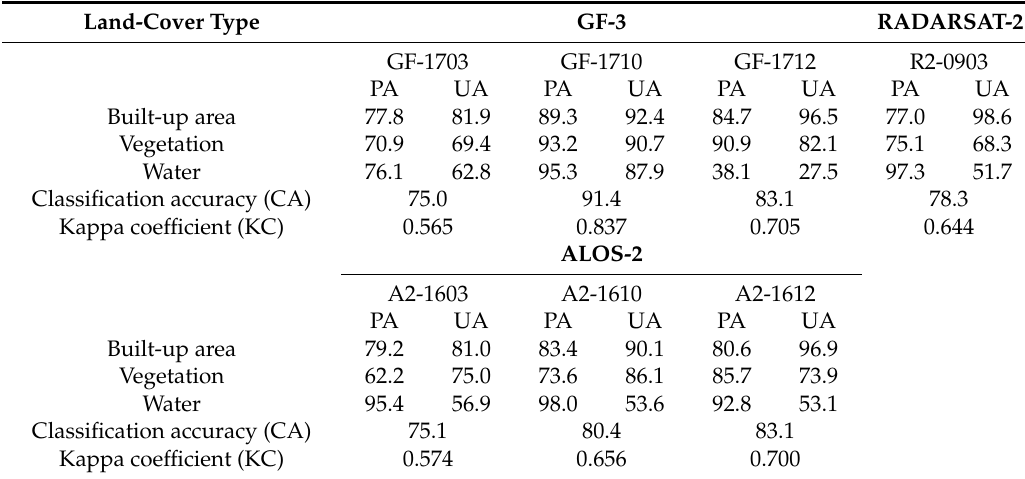
Table 4. Comparison of land-cover classification results in Beijing using images from GF-3, ALOS-2, and RADARSAT-2 data.